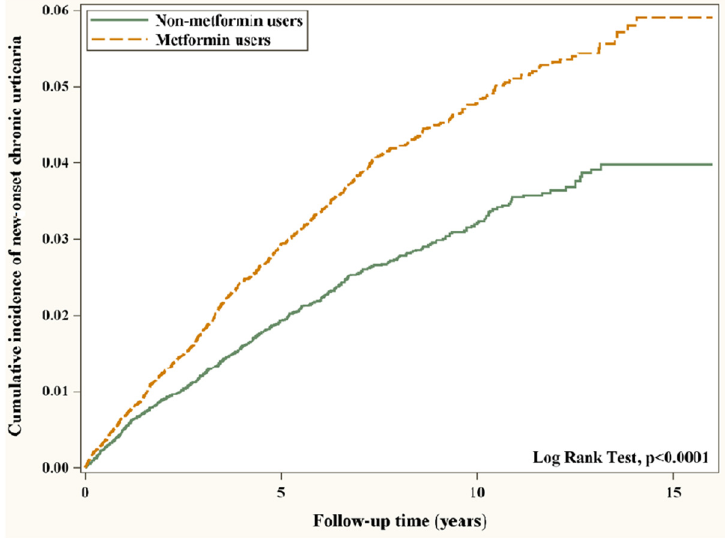
Figure 2. Cumulative incidence of new-onset chronic urticaria in T2D patients with and without metformin. Abbreviation: T2D, type 2 diabetes.